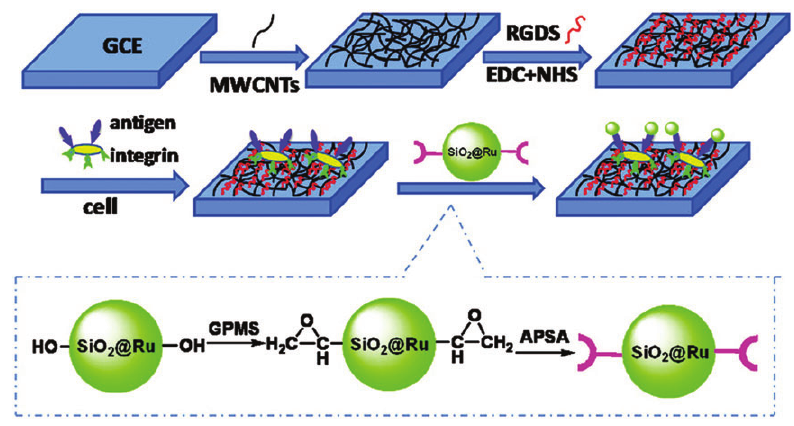
Figure 4 Schematic for the preparation of cytosensor. (Reproduced with permission from Wu et al. 2012b